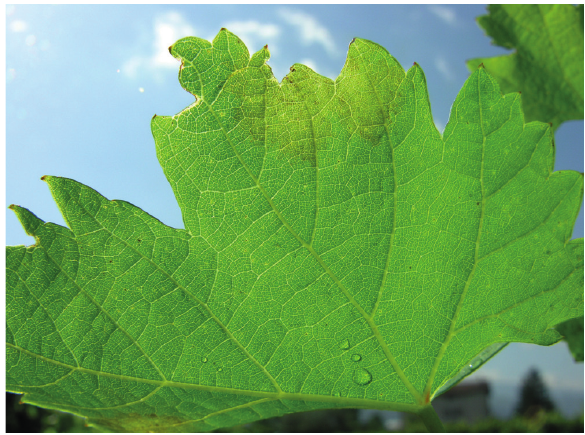
Figure 2. lesions on the adaxial leaf surface caused by secondary infections in